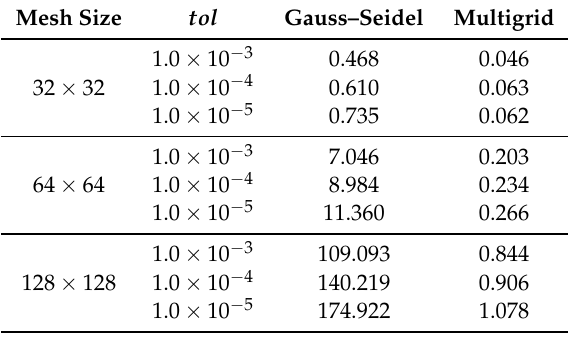
Table 6. Average CPU times for Gauss–Seidel and multigrid algorithms with different tolerances after 10 time steps.